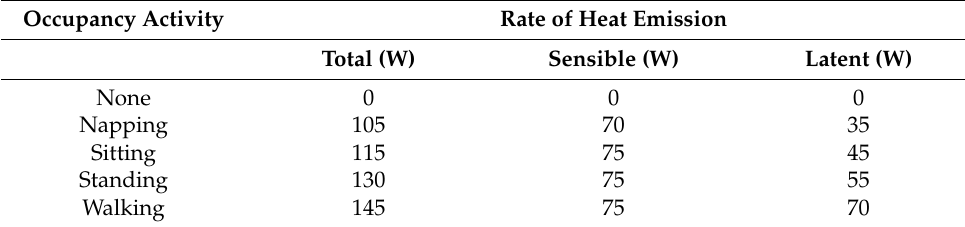
Table 3. Occupancy heat emission rates